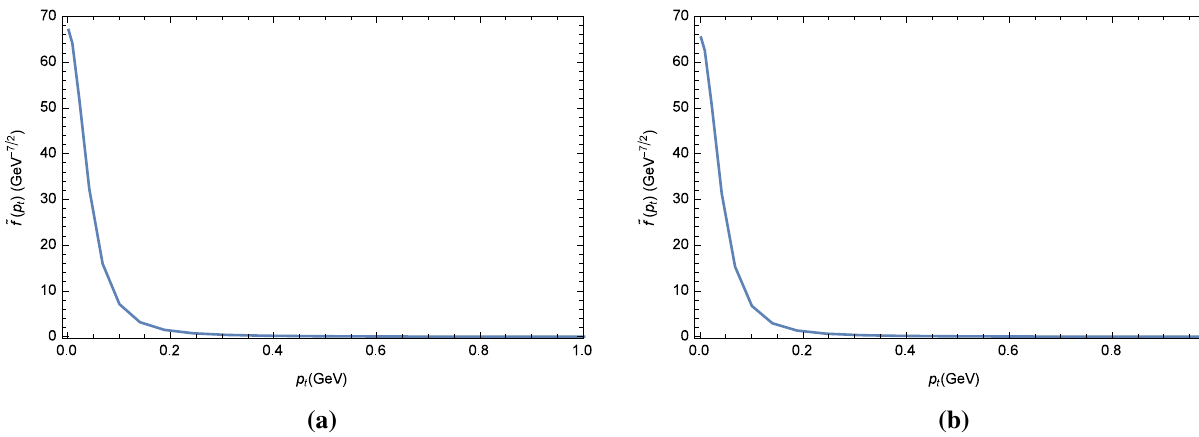
Fig. 2 Numerical results of the normalized Lorentz scalar function ˜ f ( p t ) for the X 1 ( 2900 ) in the I = 0 (a) and I = 1 (b) ¯ D 1 K molecular picture with the monopole form